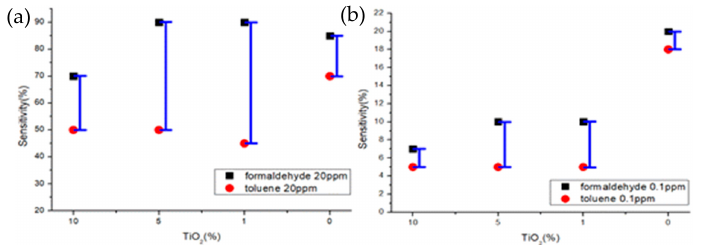
Figure 12. Sensitivity characteristics of formaldehyde and toluene gas concentrations of gas sensor by TiO 2 ratio ( a ) 20 ppm ( b ) 0.1 ppm.